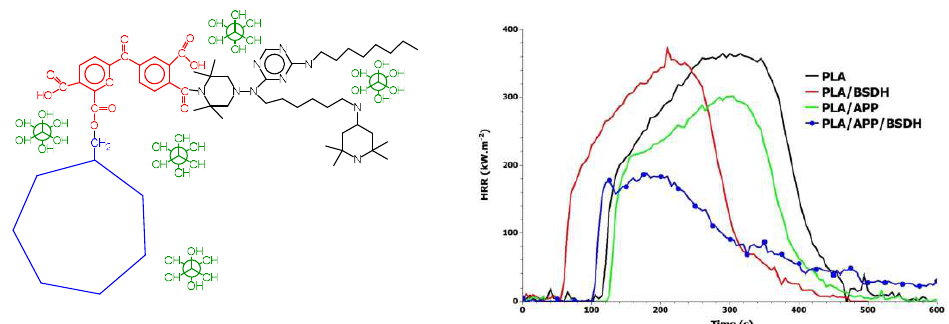
Figure 8. Structure of BSDH hybrid FR ( left ) and HRR for PLA and PLA with various FR additives ( right ). Reprinted with permission from ref. [71].